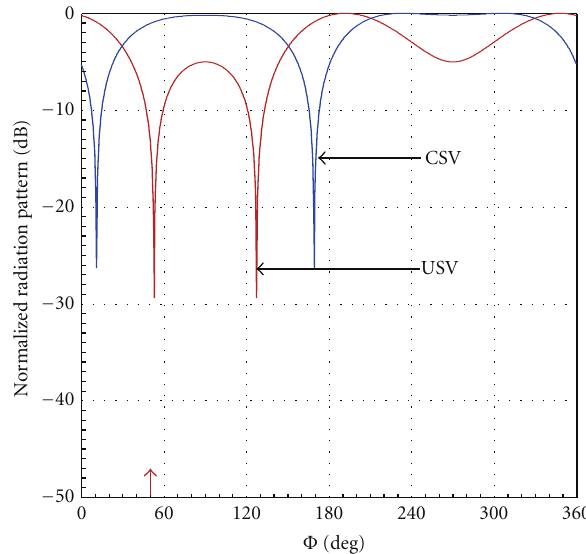
Figure 13: Pattern synthesis of 2-element array, λ /2 spacing, Φ = 0 ◦ , power: 40dB; 1 jammer: 50 ◦ , power: 0dB; USV: universal steering vector, CSV: conventional steering vector